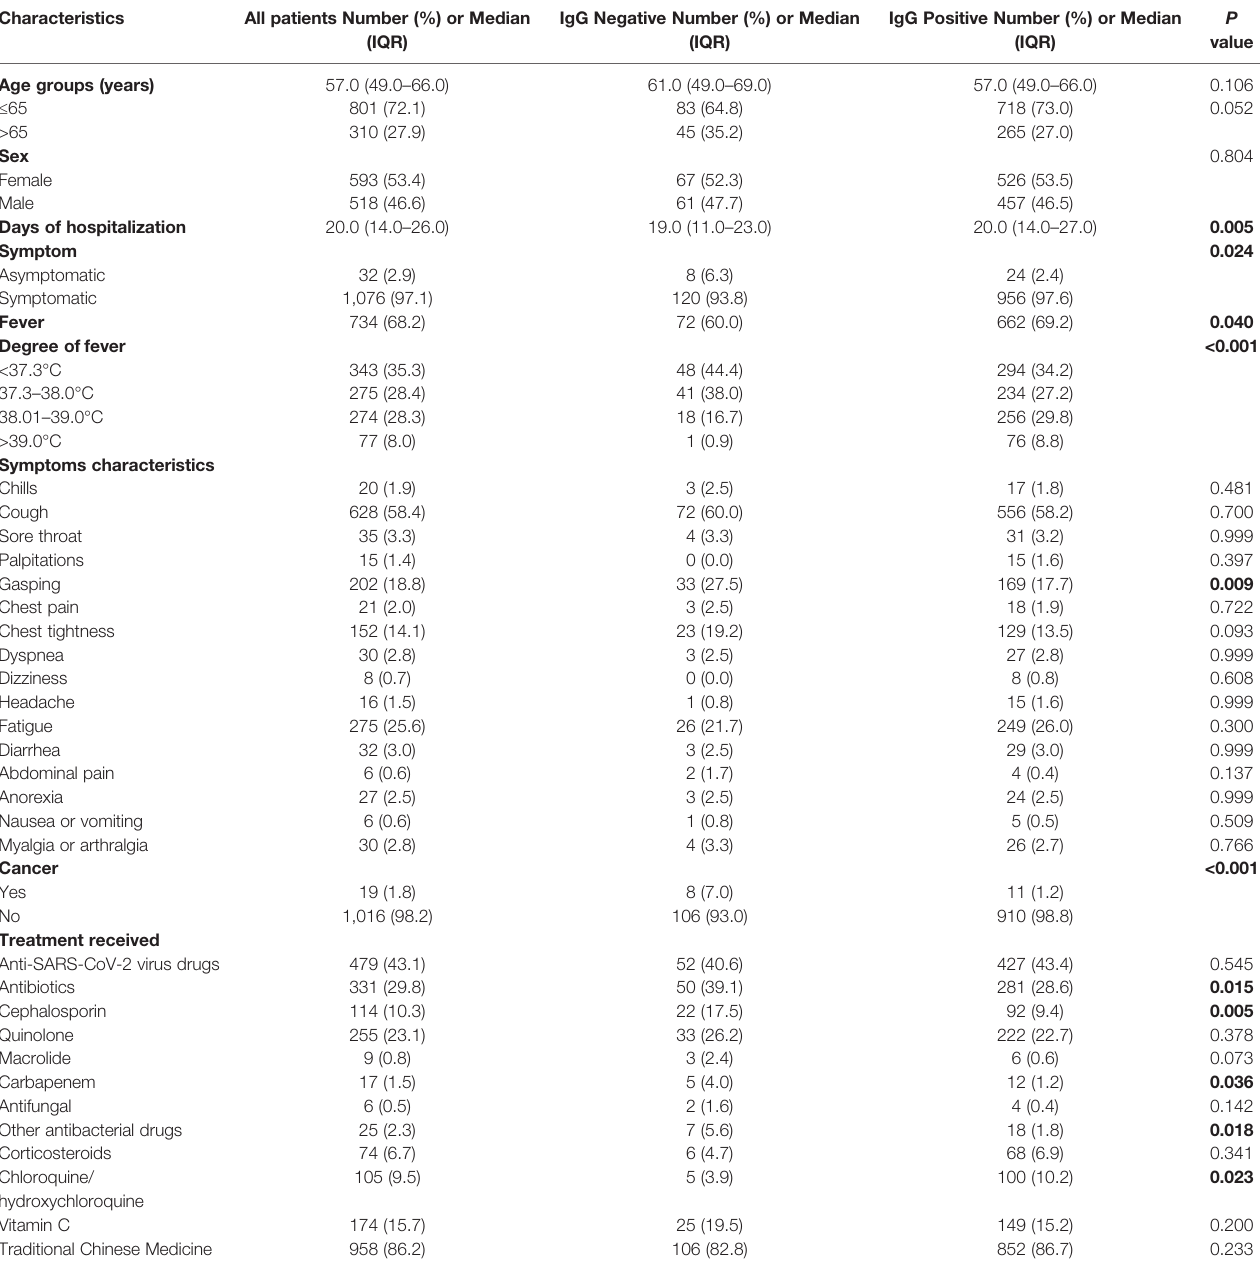
TABLE 1 | Comparison of parameters between COVID-19 patients with and without IgG antibody.